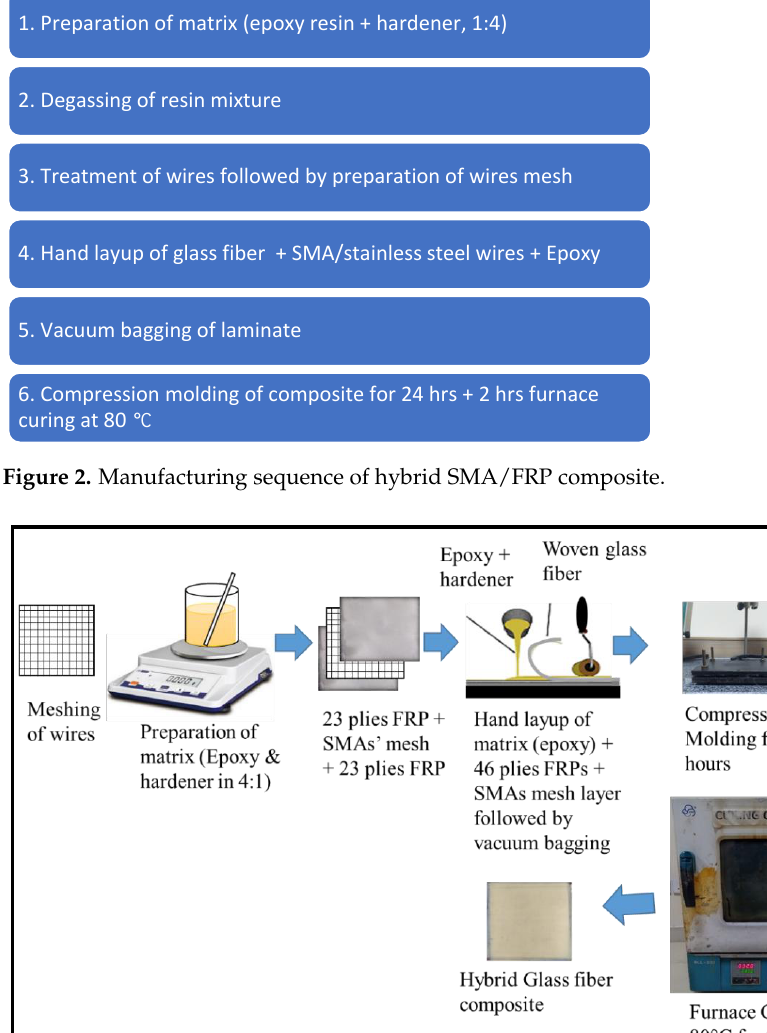
Figure 1. Reversible transformation from austenite to stress-induced martensite phase of superelastic SMA at test temperature > A f , showing energy hysteresis.